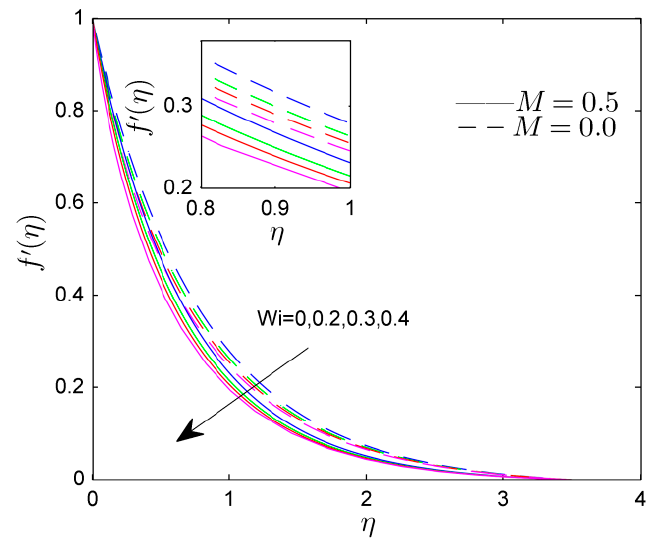
Figure 6. Effect of Weissenberg number ( Wi ) on f (cid:48) ( η ) when M = 0, 0.5 .